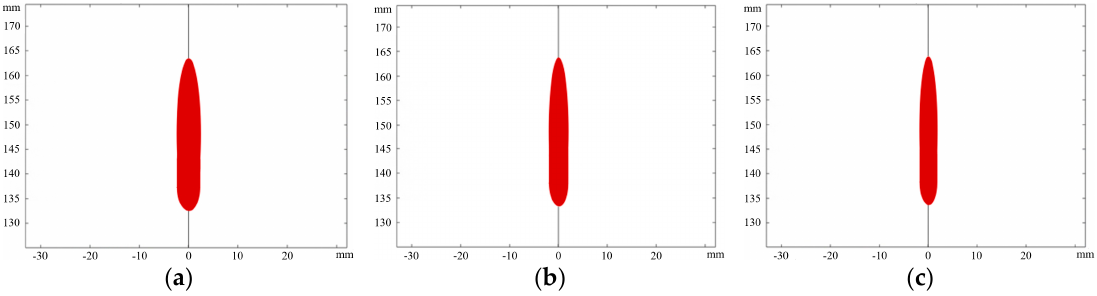
Figure 4. Simulated BFRs of phantom after ultrasonication with different combinations of acoustic power and time: ( a ) 50 W × 25.3 s, ( b ) 100 W ×10.6 s, ( c ) 150 W × 6.3 s.